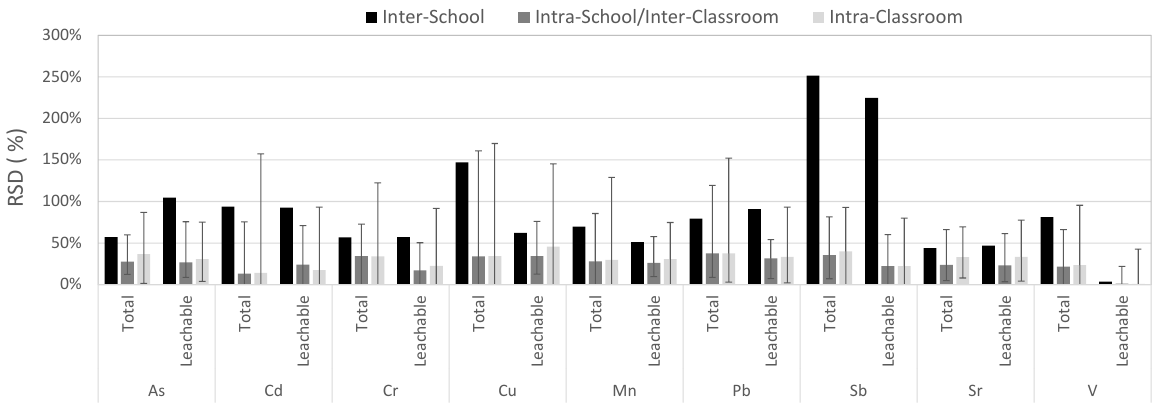
Figure 3. Relative Standard Deviation—RSD (%) values from Inter-School (mean value), Intra- School/Inter-Classroom and Intra-Classroom analyses (mean value, with lower and higher limits representing minimum and maximum RSD values